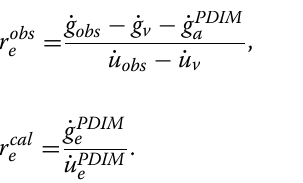
˙ g ˙ g Fig. 9, obs deviates from cal more at RUSG and BRMC than at the other AG points, because the available AG data were fewer at RUSG and BRMC (Fig. 5), and hence, more AG data should be measured to determine the rate of gravity change more accurately. In the case of obs HNSG, the cause of the inconsistency between r e and r cal e may be due to the difference in location between the AG and GNSS points. We used the GNSS data collected at AB44 in Skagway (35 km north of HNSG in Haines), because no continuous GNSS station has been installed in Haines thus far. The installation of a continuous GNSS station around HNSG should be considered in a future study to compare ground displacement with gravity change directly. The observed elastic ratios at the other three AG points (EGAN, MGVC and GBCL) average to − 0.207 ± 0.049 µ Gal/mm, which agrees with the average cal of r e within their error ranges. The difference between r v and r e (Fig. 11c–d) can be explained mainly by the density value for each subsurface layer associated with GIA. In general, the ratio of the grav- ity variation to the vertical displacement can be approxi- mately calculated by the Bouguer’s gravity gradient: where the first and second terms indicate the free-air gra- dient ( 0.3086 µ Gal/mm as a typical value; = −